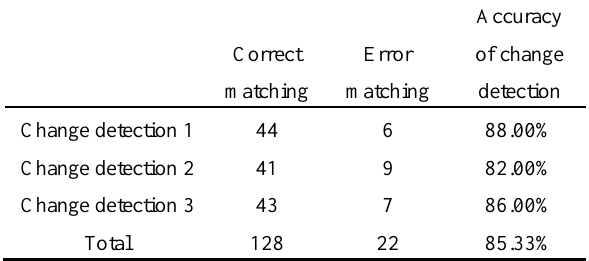
Table 3 Accuracy of change